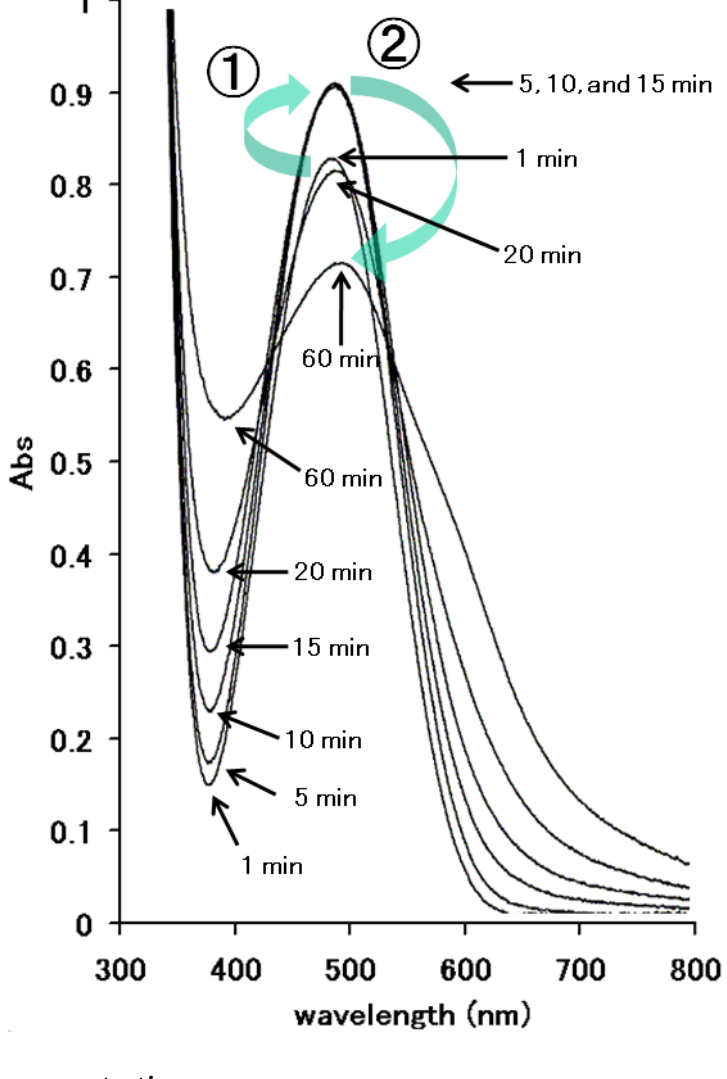
Figure 3. Alterations in the absorption spectrum of banana supernatant with MD at 30 °C at 1, 5, 10, 15, 30, and 60 min. Numbers 1 and 2 in the figure mean a change between 1min and 5 min and between 15 min and 60 min,